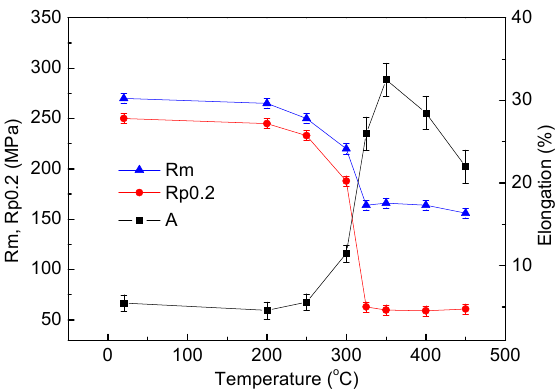
Figure 8. Variation of the strength and elongation as a function of annealing temperature.